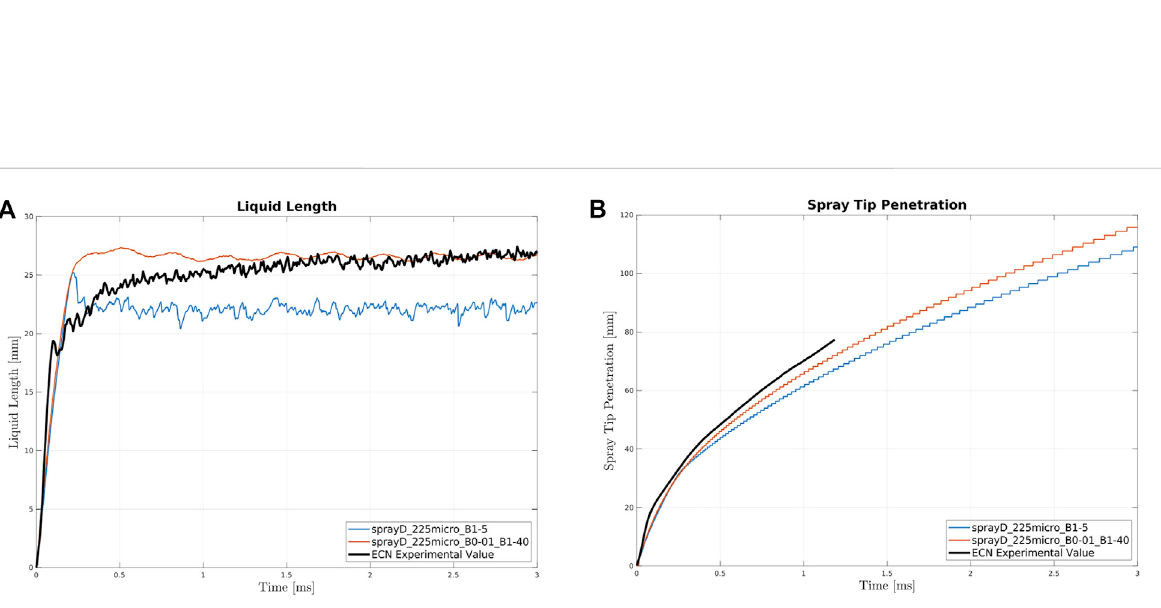
FIGURE A2 Liquid Length (A) and Spray Tip Penetration (B) for Spray D at varying break-up constants: in blue the one used in this work, in orange the optimized